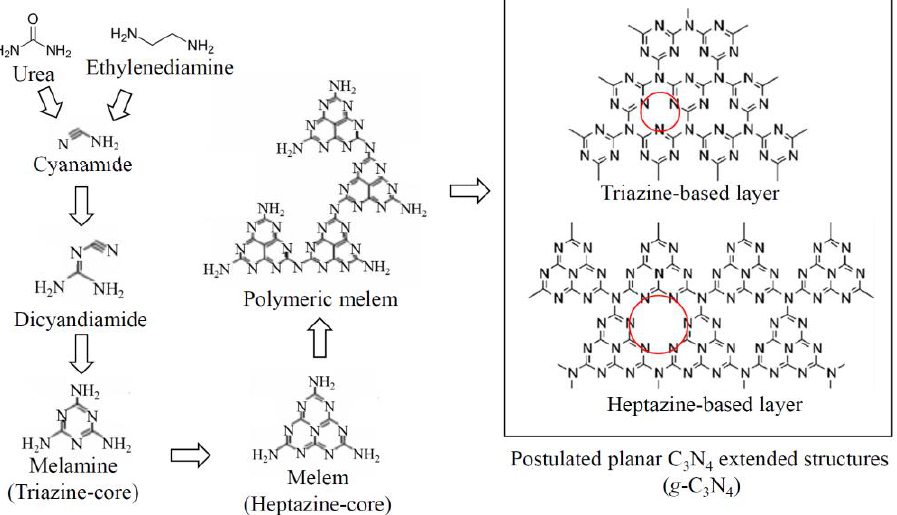
Figure 8. Structures of triazine-based and heptazine-based g-C 3 N 4. Reprinted with permission from Ref. [164] Copyright 2019, Elsevier.